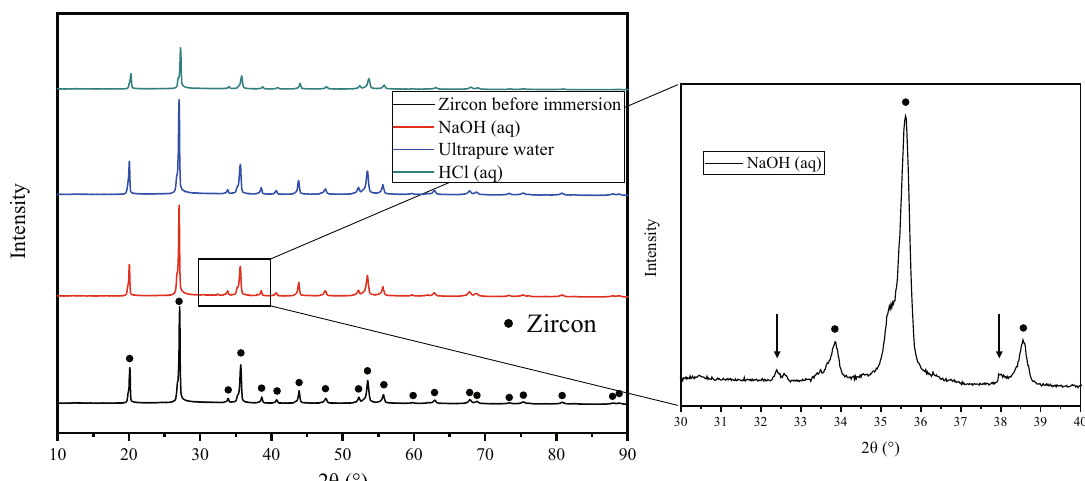
Fig. 4 X-ray powder diffraction pattern of crushed zircon powder before and after immersing in each solution. Left panel shows the pattern before immersion, and after immersing in 0.1 M NaOH (aq), ultrapure water, and 0.1 HCl (aq). Right panel shows unclear peaks at 32.5° and 38° in the pattern after immersing in 0.1 M NaOH (aq).